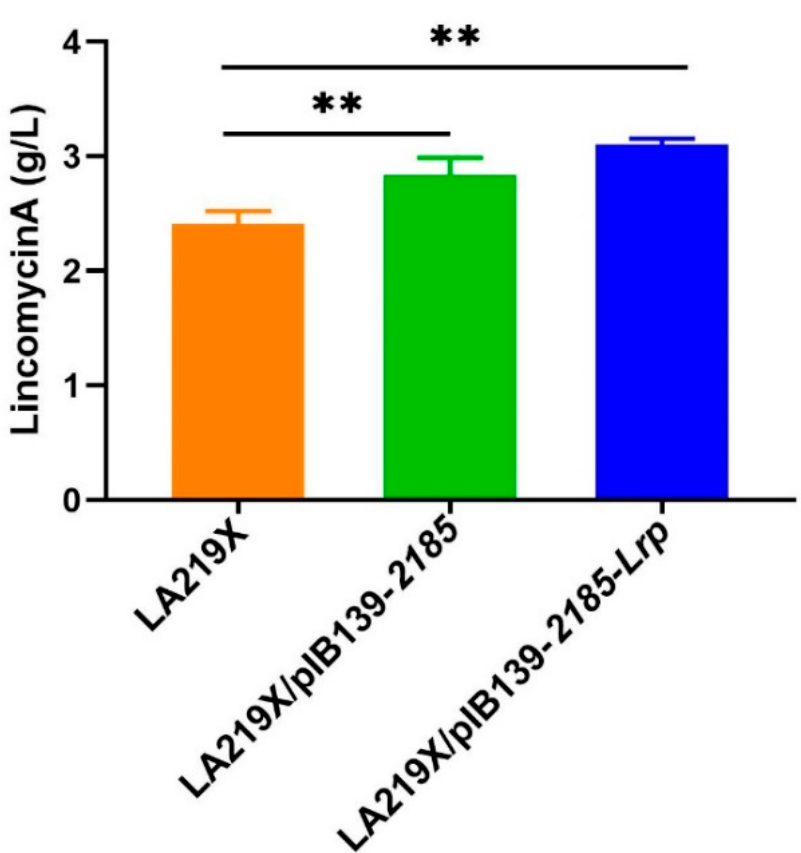
Figure 8. Lin-A production of S. lincolnensis LA219X and its derivatives. ** p < 0.01 .